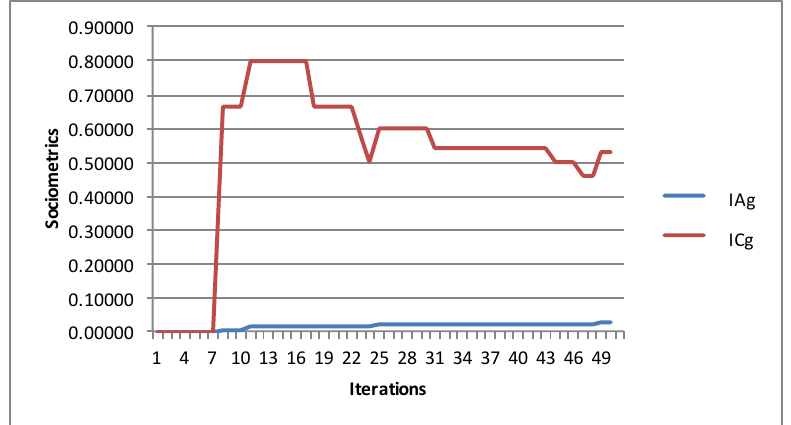
Figure 12. Temporal evolution of sociometrics in the scenario of Roberts [5] in the second validation experimentation, in which this scenario was not used in the training